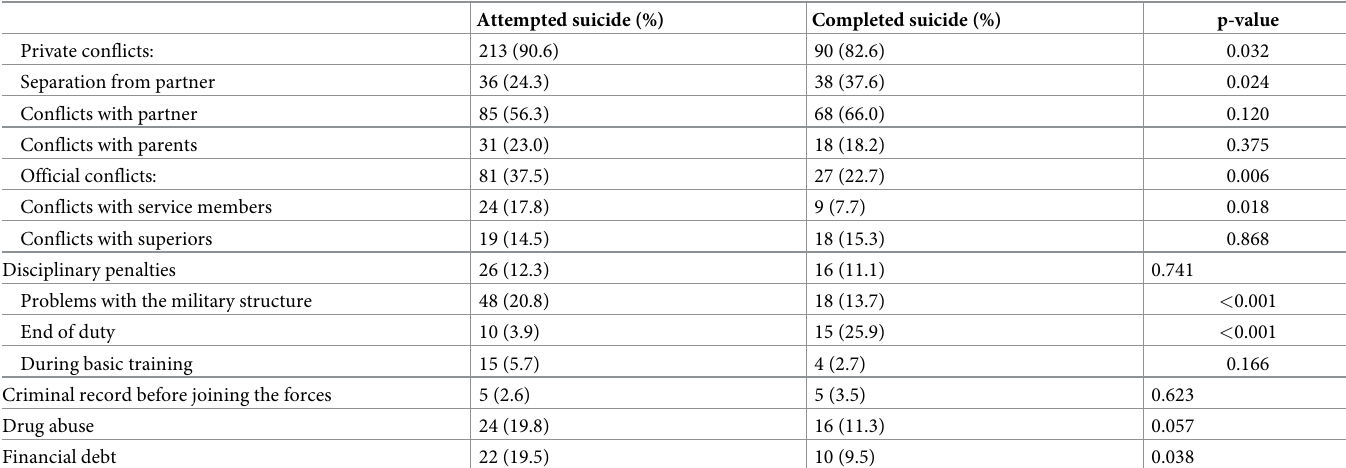
The analysis of the deployment history revealed that service members of the suicide group